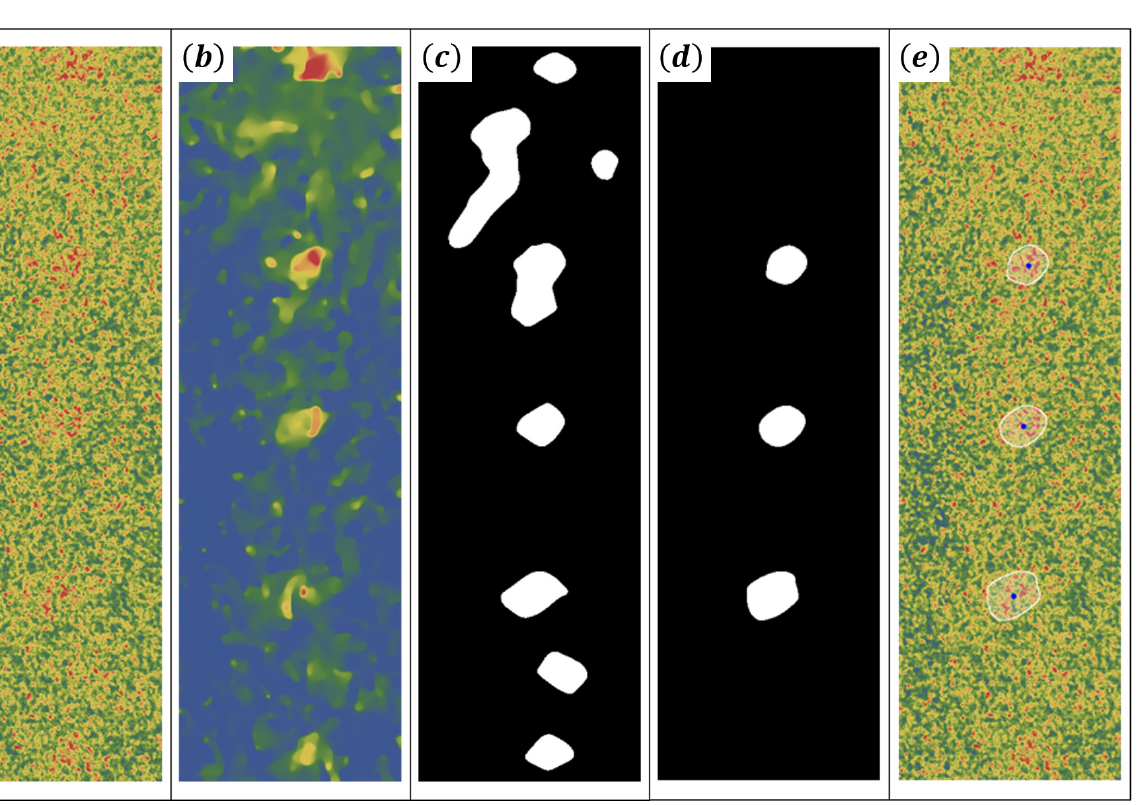
Figure 11. An example of segmentation improvement by MRIF: ( a ) horizontally cropped pre-processed image—note the very low CNR in the upper half of the image; ( b ) global SCTMM filtering result; ( c ) first segment estimates; ( d ) updated segments output by MRIF; ( e ) output segment overlays for ( a ). Note that the top- and bottom-most segments from ( c ) are not present in ( d , e )—this is the correct behaviour, since one can visually see in ( a , b ) that the corresponding bubbles are partially outside of the FOV, and thus are not eligible for